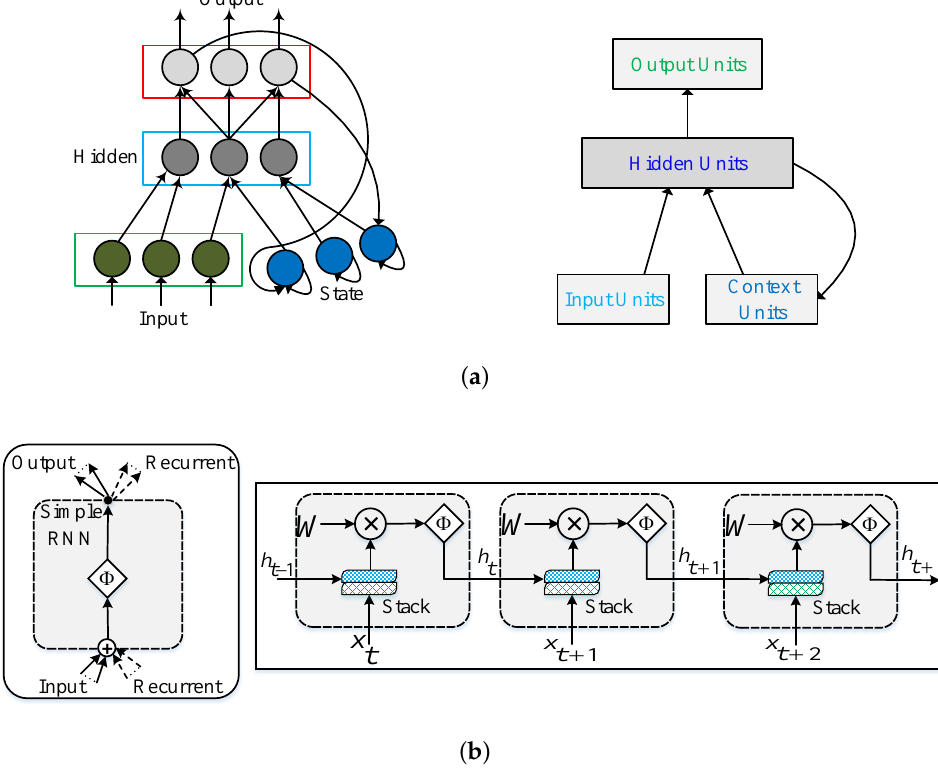
Figure 1. Basic early recurrent neural network (RNN) architectures and present RNN architecture: ( a ) early RNN models of Jordan ( Left ) [42] and Elman ( Right ) [43] and ( b ) present RNN structure and its interconnected blocks